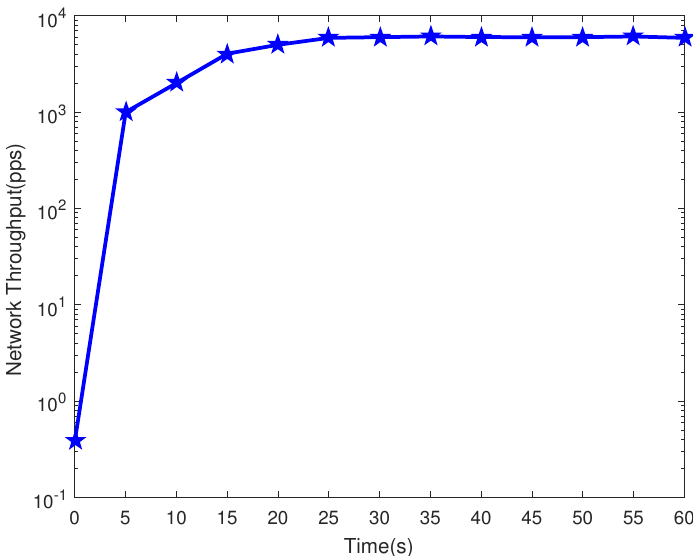
Figure 5. Change Diagram of SFlow Packets in Network Attack Process. During the network attack, the rapid increase of sFlow bytes and sFlow packets make the transmission traffic grow rapidly, and the CPU occupancy and memory occupancy also increase significantly from 0 to 30 s. After that, with sFlow bytes and sFlow packets at a stable value, the attack is also at a critical moment, and the CPU occupancy reaches 100%. After 20 s, the packets are continuously sent. After 50 s, the CPU occupancy and memory occupancy reach the maximum value, and the CPU and memory change during the network attack, as in Figure